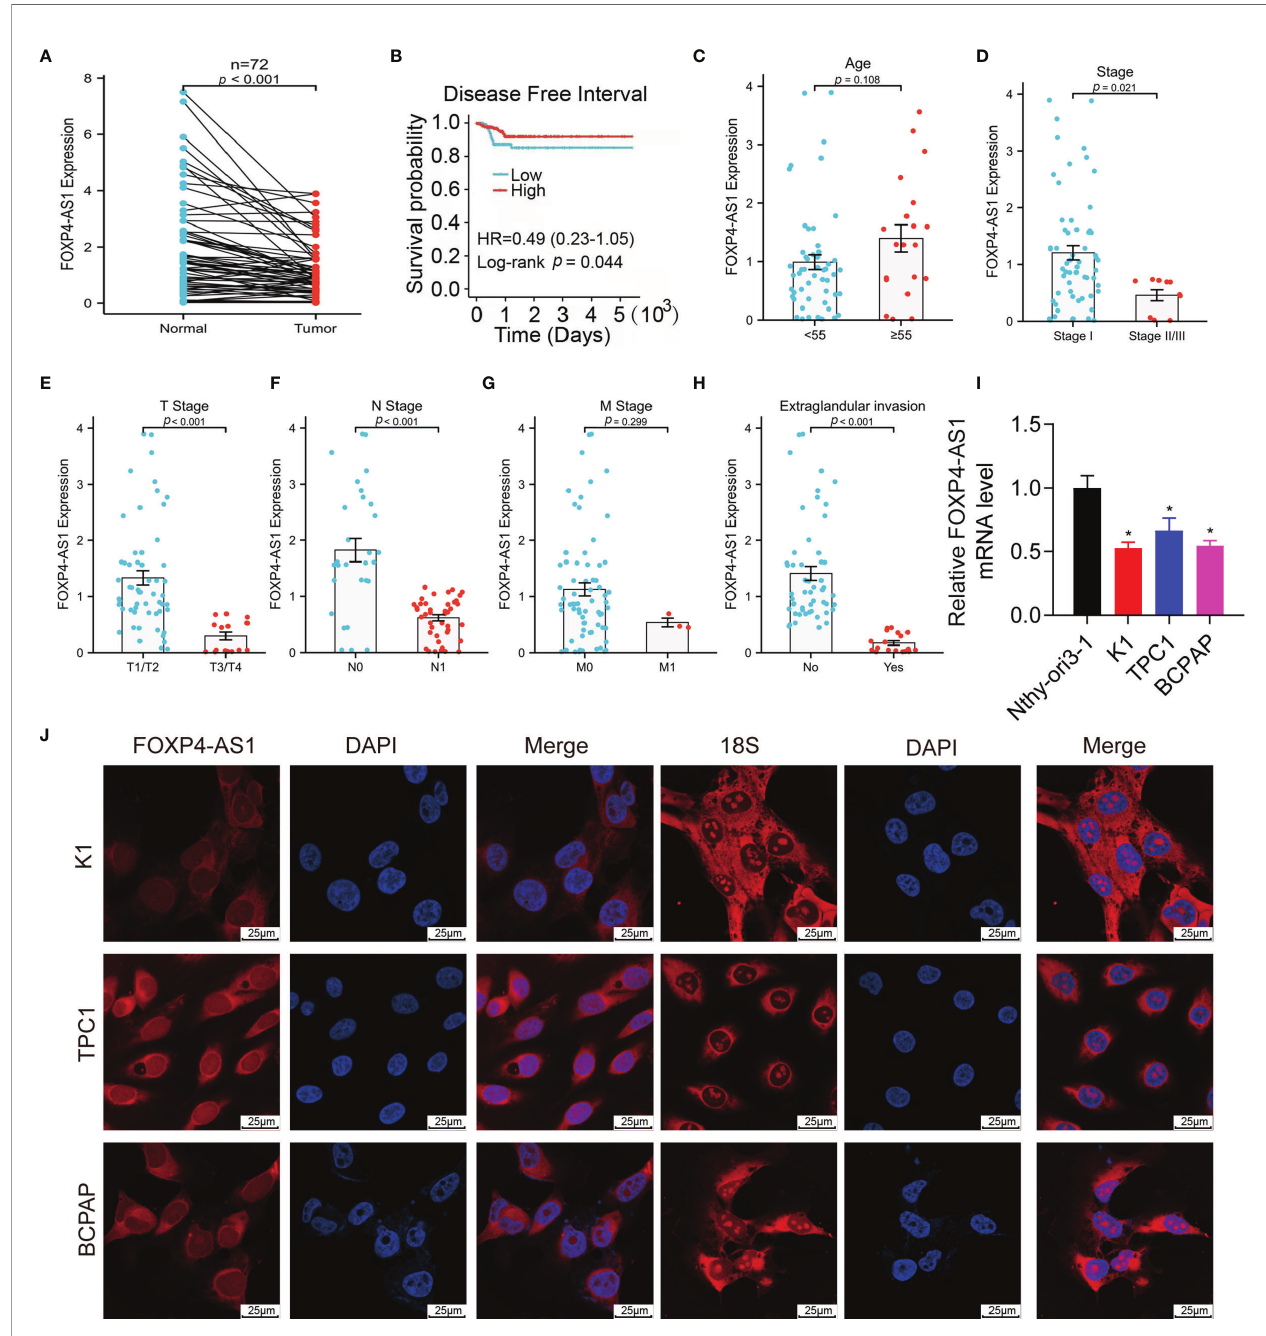
FIGURE 1 | FOXP4-AS1 is low expressed within papillary thyroid carcinoma and localized in the cytoplasm. (A) FOXP4-AS1 levels in PTC and adjacent samples. (B) The DFI of PTC patients with differential FOXP4-AS1 expression from TCGA database by Kaplan – Meier analysis. (C) FOXP4-AS1 levels in patients with PTC above age 55 or below 55. (D) FOXP4-AS1 levels in early stage and advanced stage of patients. (E) FOXP4-AS1 levels in T3/4 stage and T1/2 stage of patients diagnosed. (F) FOXP4-AS1 levels in N1 stage and N0 stages of patients. (G) FOXP4-AS1 levels in the M1 stage and M0 stage of patients. (H) FOXP4-AS1 levels in patients with extraglandular invasion or without invasion. (I) FOXP4-AS1 levels in three cell lines of papillary thyroid carcinoma (K1, BCPAP, and TPC-1) and Nthy-ori3-1 normal cells. (J) FOXP4-AS1 was distributed primarily in the cytoplasm of BCPAP, K1, and TPC-1 cells by FISH. Scale bar = 25 m m. *p <